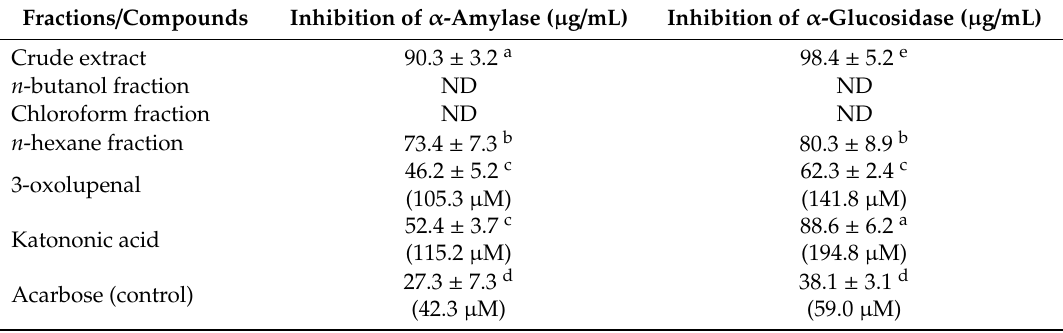
Figure 2. Inhibitory effect of N. oppositifolia crude extract and different fractions against ( A ) pancreatic α -amylase, and ( B ) pancreatic α -glucosidase at 100 μ g/mL concentration. Data are presented as mean ± standard deviation values of triplicate determinations. Different superscripts letters (a–c) for a given value within the figure are significantly different from each other (Duncan’s multiple range test ( p < 0.05). Table 1. Inhibition of pancreatic α -amylase and α -glucosidase activities (IC 50 values) by different fractions and purified compounds (katononic acid and 3-oxolupenal). Values are means of three experiments ± SD. The values followed by different superscript (a–e) differ significantly ( p < 0.05).